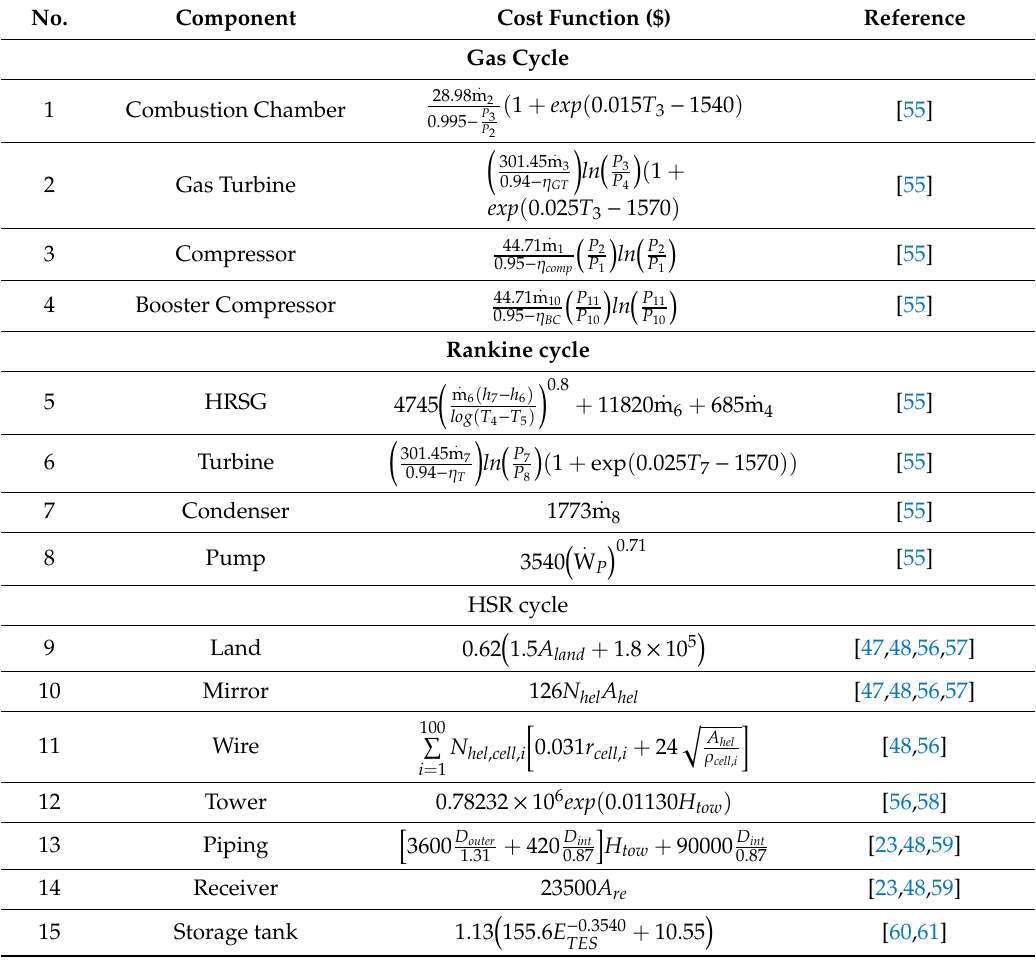
Table 7. Cost functions of installation and capital